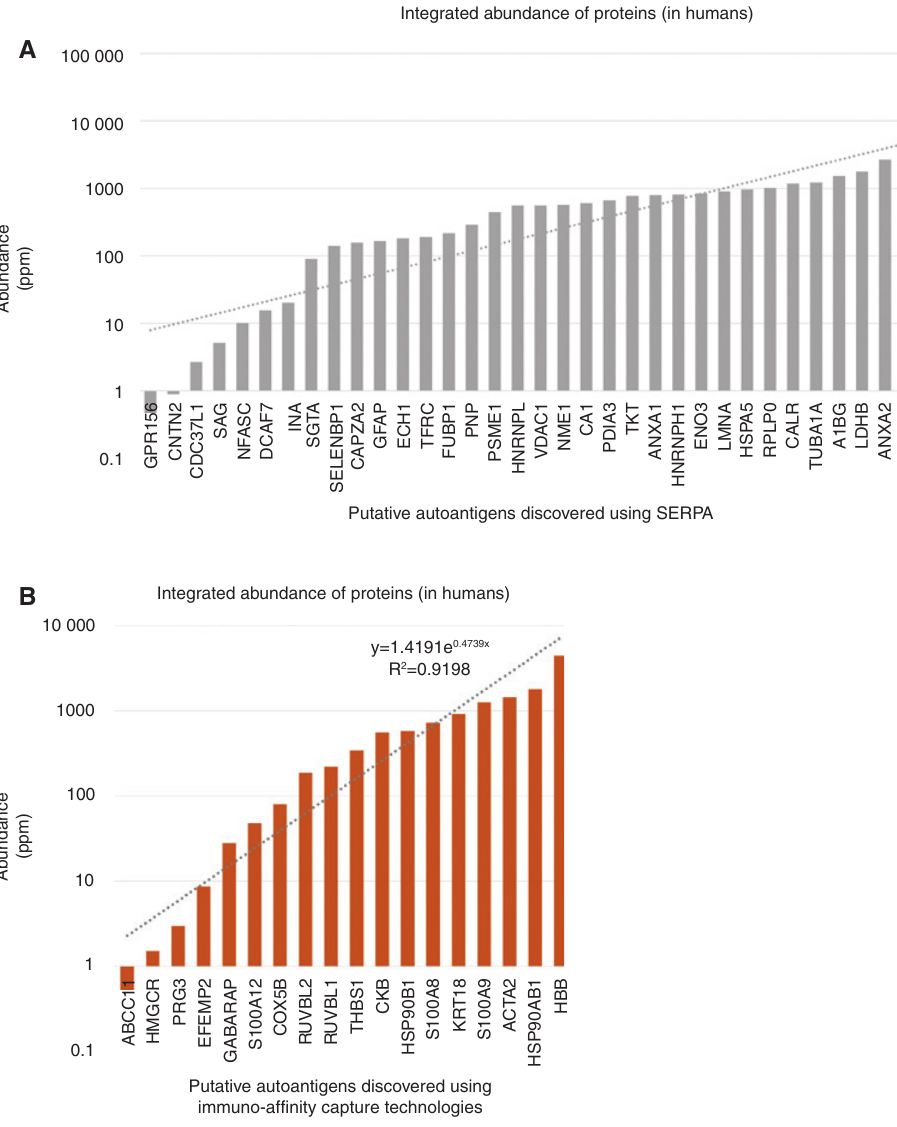
Figure 2: Meta-analysis of Immunoproteomic data generated using MS-based approaches. The vertical axis represents the integrated protein abundance in ppm in a logarithmic scale. PPM (parts per million) is the unit of abundance that is used to quantify relative abundance within the proteome (35). (A) The horizontal axis represents each protein discovered using SERPA from 24 studies (8, 11–34). The histogram is clearly skewed towards high abundance proteins. Among these proteins, α -enolase, annexin II and actin appear as autoantigens in multiple autoimmune studies that employed SERPA. We notice that these notorious antigens are also on the higher side of the abundance histogram. This shows that SERPA maybe biased towards picking up high abundance proteins as putative autoantigens. (B) The horizontal axis represents each protein discovered using immuno-affinity capture technologies such as AMIDA, CIC and SELDI-TOF from 12 studies (38–42, 46–52). The vertical axis represents the integrated protein abundance in ppm (35) in a logarithmic